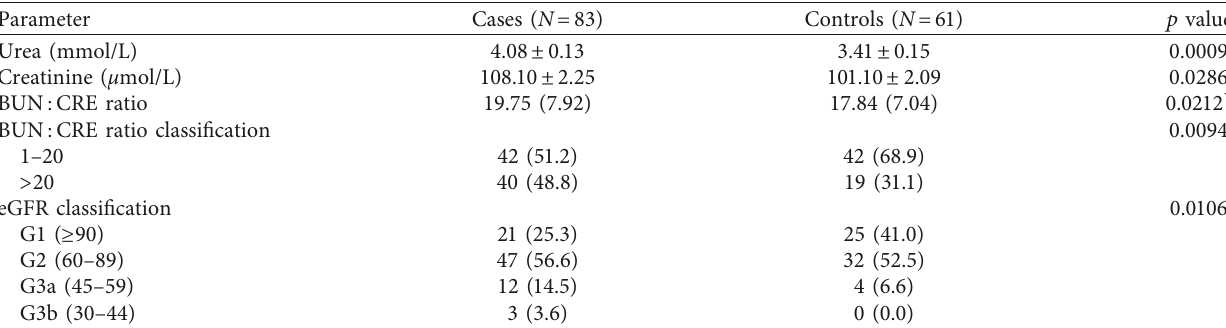
Table 3: Renal function of